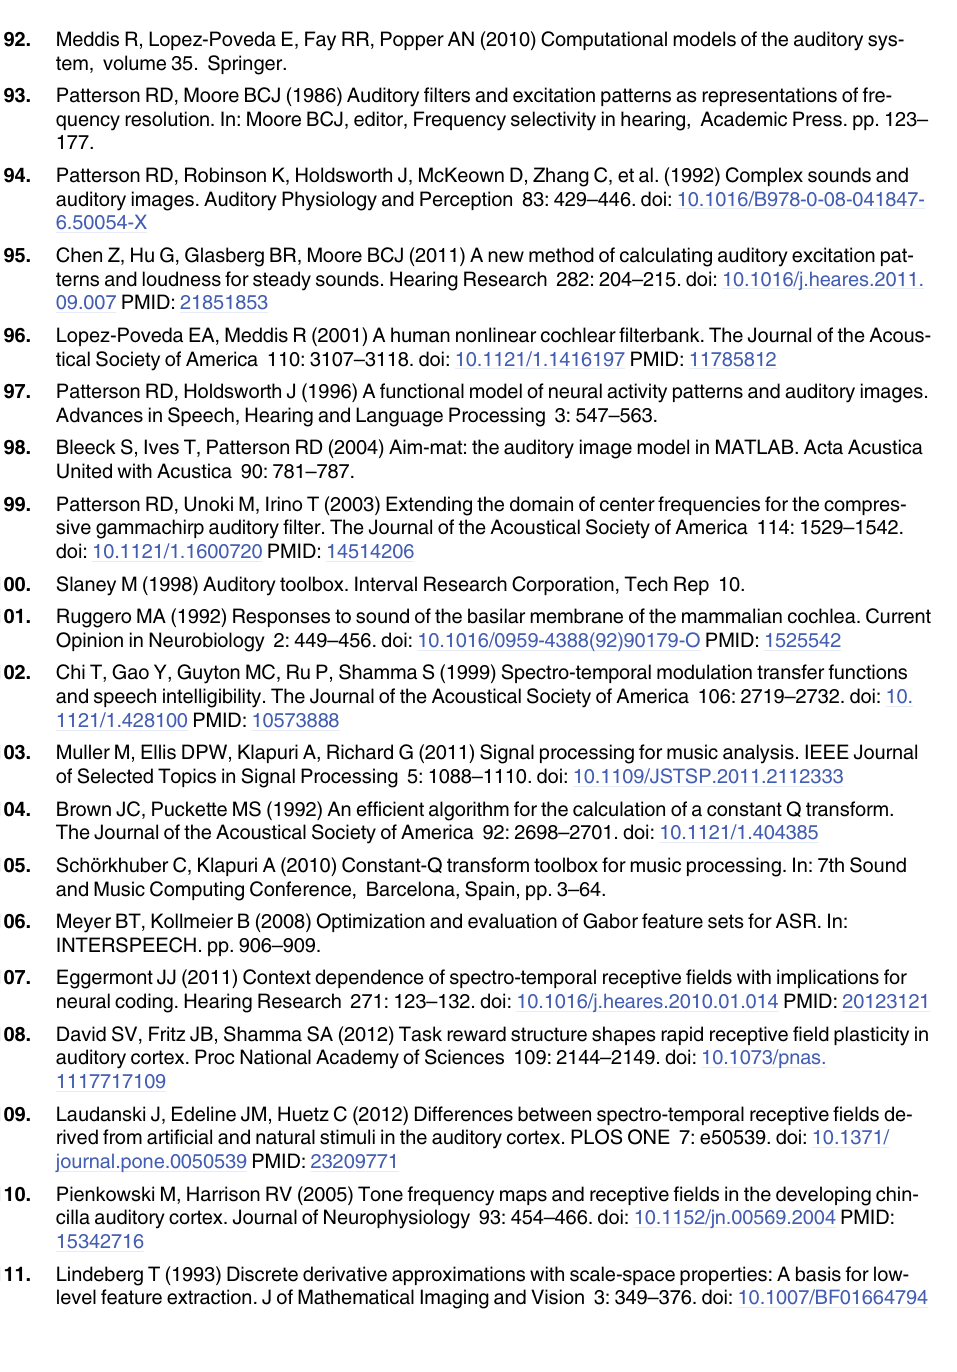
PLOS ONE | DOI:10.1371/journal.pone.0119032 March 30,